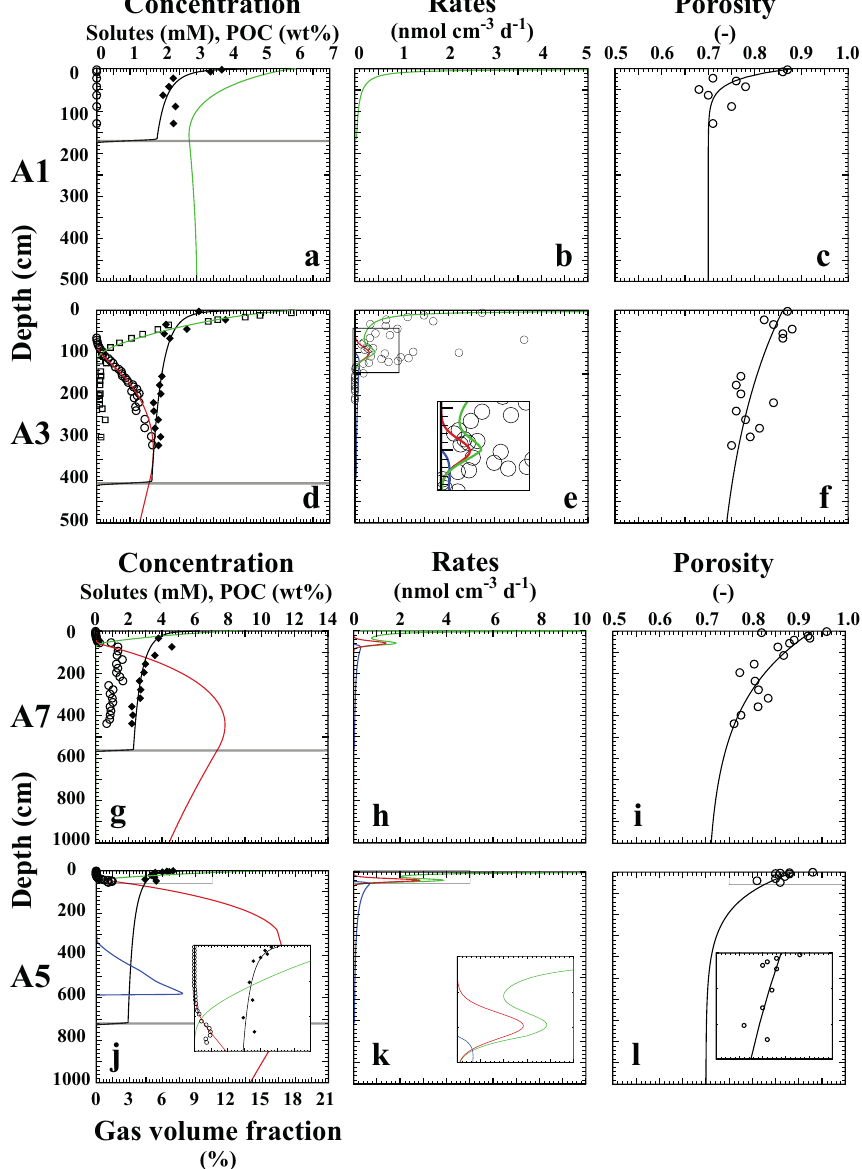
Fig. 5. Simulated methane (red), sulphate (green) and POC profiles (black) (panels a , d , g , j ), gas volume fraction (blue) (panel j ); sulphate reduction (green), AOM (red) and methanogenesis (blue) rate profiles (panels b , e , h , k ); and porosity profiles (panels c , f , i , l ) plotted against the available measured data (methane – open circles, sulphate – open squares, POC – filled diamonds, sulphate reduction rates – open circles in panel e , and porosities – open circles in panels c , f , i , l ) for Stations A1 ( a , b , c ), A3 ( d , e , f ), A7 ( g , h , i ) and A5 ( j , k , l ). The bottom (base) of the HORM is noted in panels (a) , (d) , (g) , and (j) by a horizontal gray line. The inserts in panels (e) , (j) , (k) , (l) represent a zoom of the respective boxed